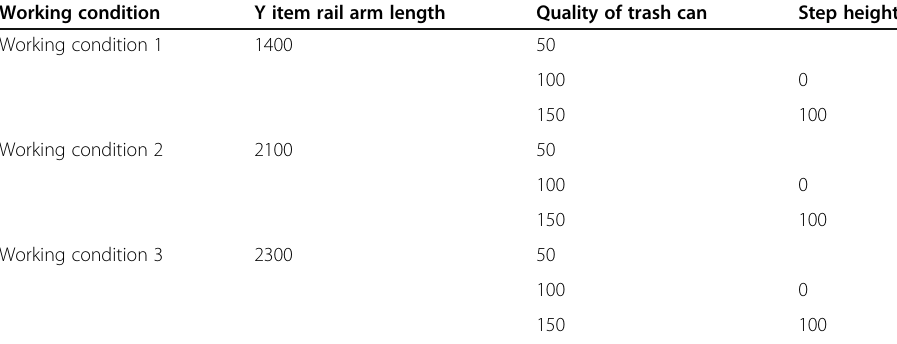
Table 1 Main three operating conditions settings Working